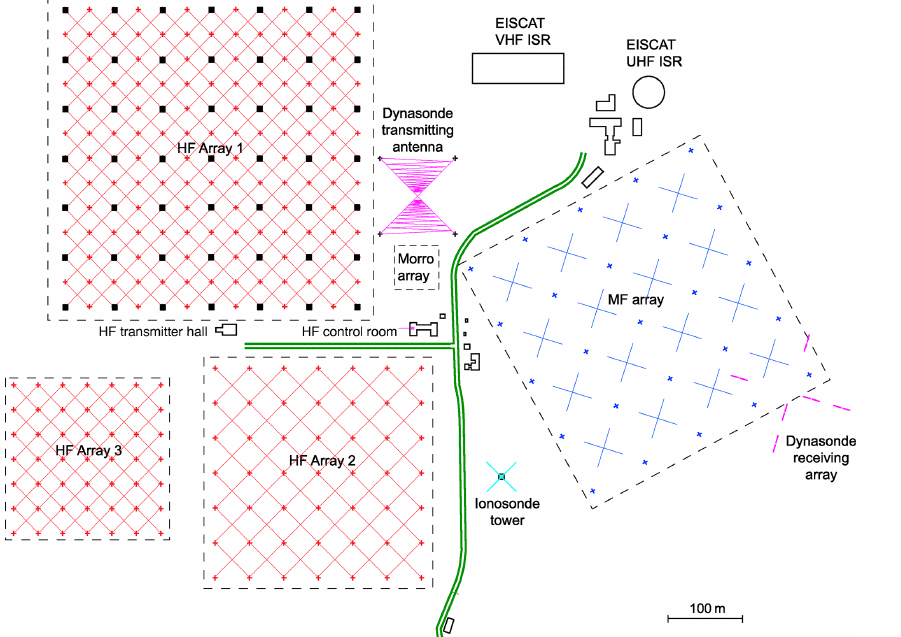
Figure 2. Schematic diagram showing the layout of antennas and major infrastructure at the Ramfjordmoen site (to scale). The red diagonal lines in the HF arrays represent the full-wave antennas attached to wooden masts at each end (small red crosses). The feed points of each crossed-dipole antenna is where the red lines cross each other. The black squares in HF Array 1 show the original 23m tall wooden masts to which the low-frequency antennas were attached (until 1985), and the red crosses in Array 1 show the 12m tall wooden masts added around 1989 for the modified array containing higher-frequency antennas similar to Array 3. The Dynasonde (HF sounder), housed in the same building as the HF control room, and its associated antennas are an integral part of the Heating facility. The EISCAT IS radar antennas and buildings are shown at the upper right. The large blue crosses show the crossed half-wave dipoles of the 2.78MHz MF (medium-frequency) radar transmitting antenna, suspended between masts (small blue crosses). The ionosonde tower supports the transmitting antenna for the University of Tromsø’s digisonde. The Morro array is an antenna for a 56MHz MST (mesosphere–stratosphere–troposphere) radar from the University of Tromsø. The green double line shows the road, and the unlabelled boxes are buildings or huts with optical and other